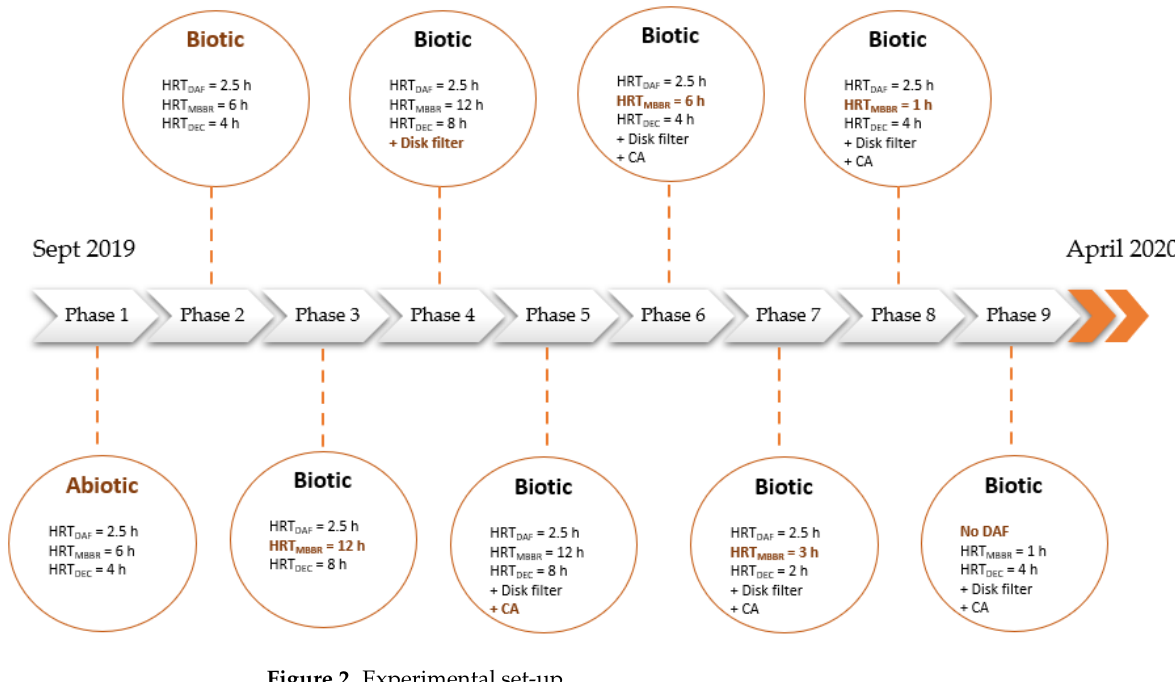
Figure 2. Experimental set-up.